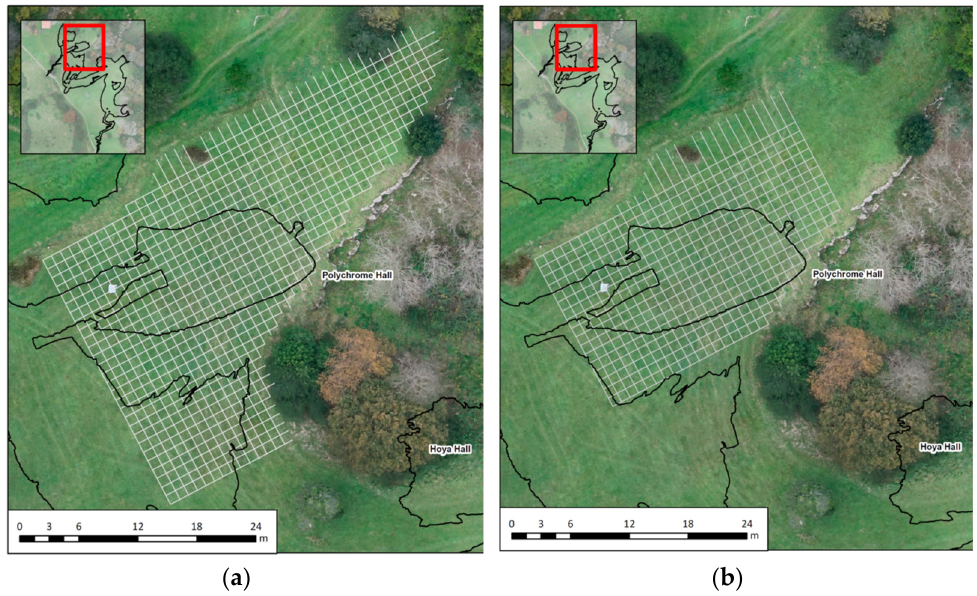
Figure 7. The location of GPR profile grids (orthogonal 2D profiles spaced every 1 m) in the overlying rock strata and the lapiés zone of the Polychrome Hall ceiling, carried out with the ( a ) 400 MHz and ( b ) 900 MHz antennas.